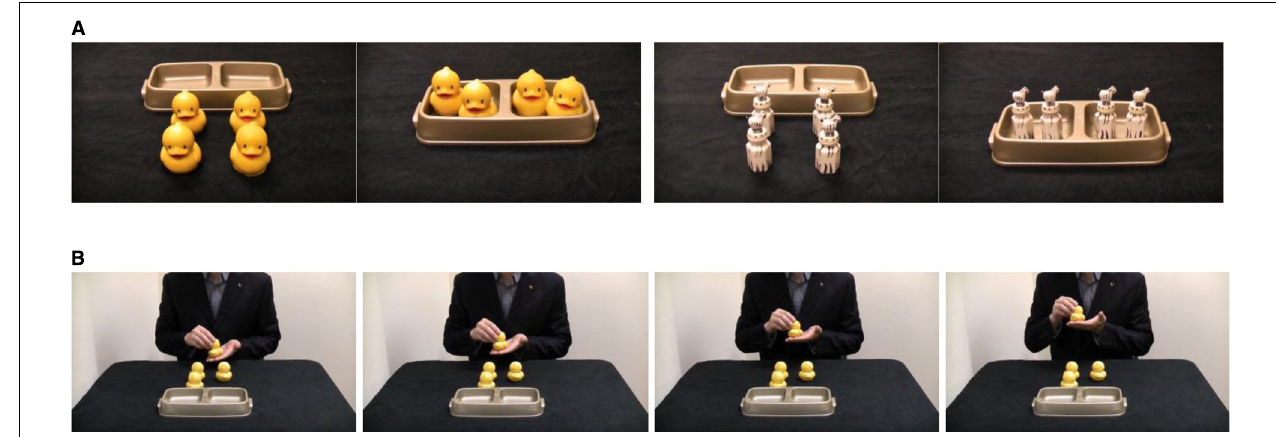
FIGURE 1 | Photographs of the experimental materials (A), which consist of sets of four visually-identical ducks, four visually-identical zebras, and bins to sort the objects into. Within each set, two objects are heavy and